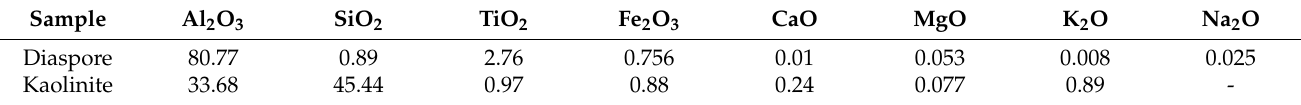
Figure 1. XRD patterns of the purified samples: ( a ) diaspore; ( b ) kaolinite (D = Diaspore, K = Kao- linite). K = Kaolinite). Table 1. Chemical compositions of the purified samples (mass fraction, %). Table 1. Chemical compositions of the purified samples (mass fraction,